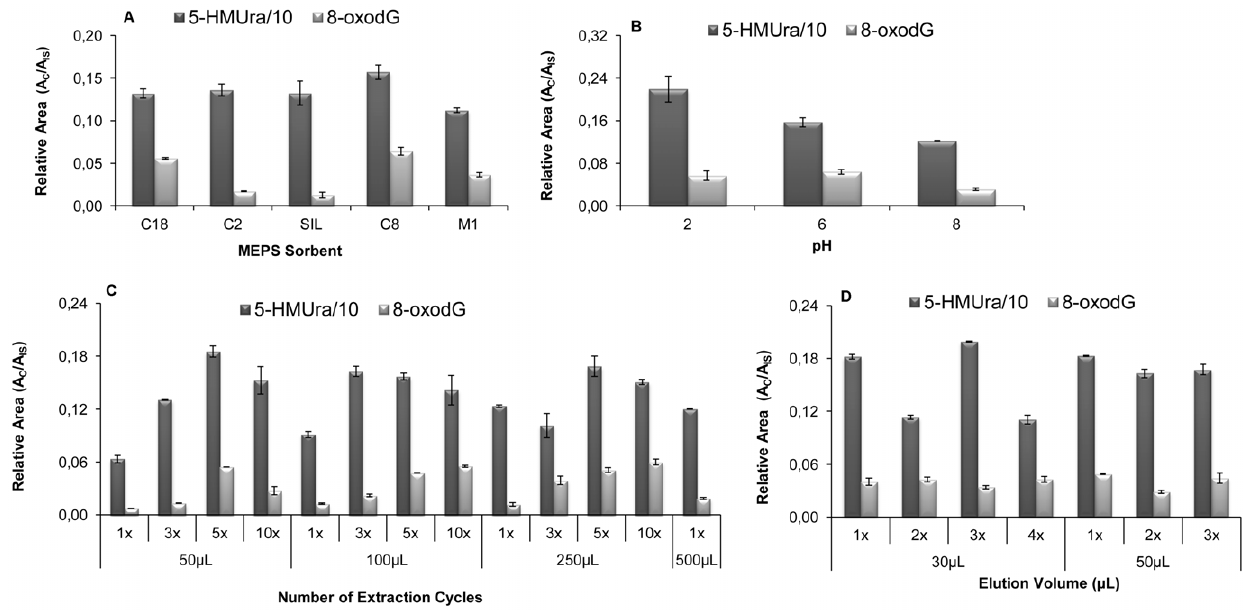
Figure 2. Optimisation results of the eVol H MEPS extraction methodology for quantification of oxidatively damaged DNA biomarkers in urine. (A) Comparison the performance characteristics (relative peak areas - A C /A IS , obtained for each adsorbent) of different MEPS adsorbents for isolation of target DNA damage biomarkers from urine; (B) effect of pH value on the extraction efficiency; (C) influence of number of extraction cycles (extraction-discard) as a function of applied sample volume; (D) effect of elution volume on UHPLC-PDA response. Errors bars show the standard deviation of the mean ( n =3).